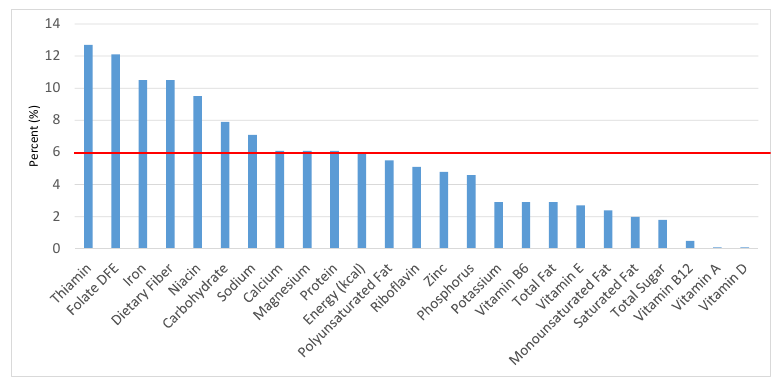
Figure 8. Breads, rolls and tortilla as sources of energy and nutrients for children 4–8 years old ( N = 1917, daily intake data): DFE = Dietary Folate Equivalents; solid red line represents percentage of energy (kcal) provided in the diet relative to nutrients—nutrients above the red line show the grain food’s contribution to nutrient density.